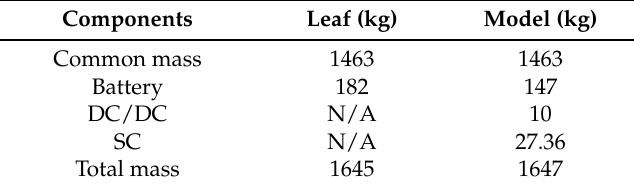
Table 6. Component configuration.